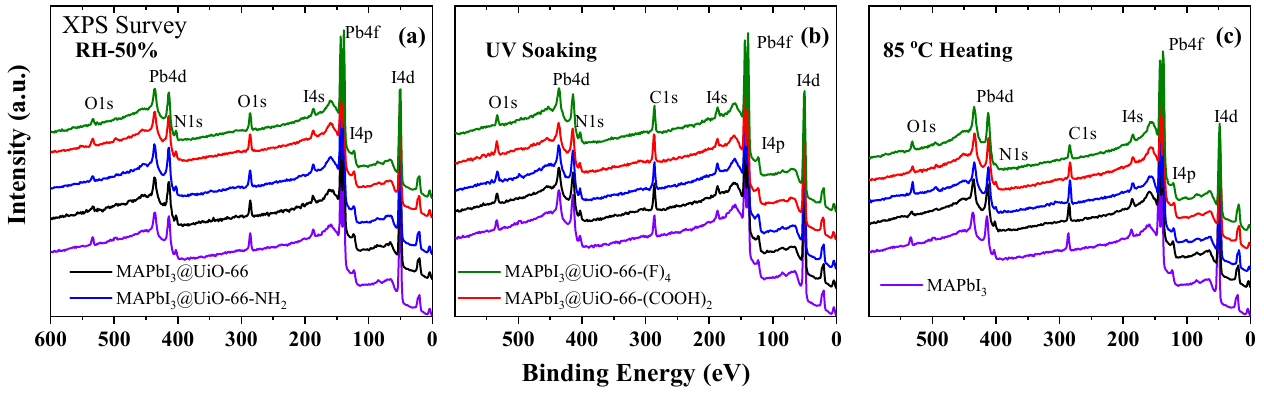
Figure 9. XPS survey spectra of the MAPbI 3 @UiO-66 nanocomposites before and after storage at ( a ) RH 50%, ( b ) UV light, and ( c ) annealing at 85 °C for 45 days. Table 1. The positions of the Pb 4f 7/2 and I 3d 5/2 peaks of the MAPbI 3 samples before and after various treatments (RH-50%, UV, and annealing at 85 °C).